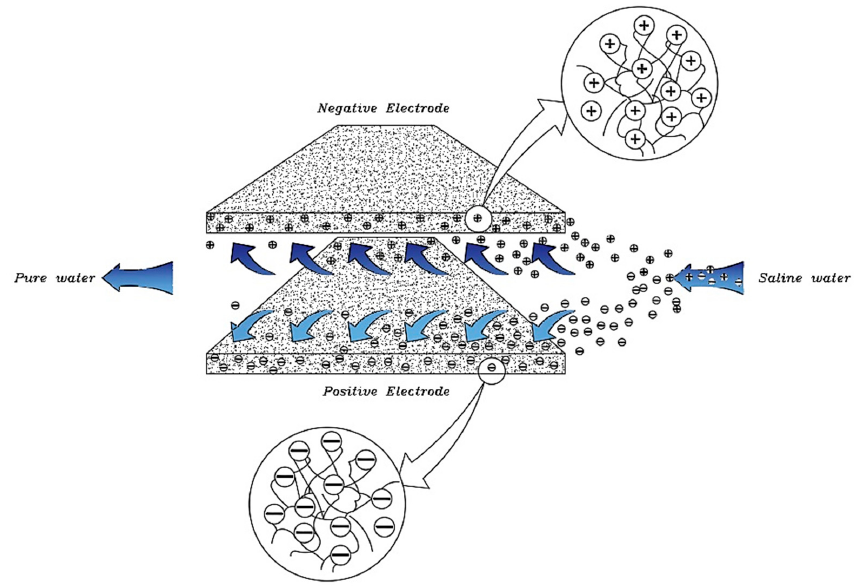
Figure 10. Sorption phenomenon in water desalination process by CDI method.